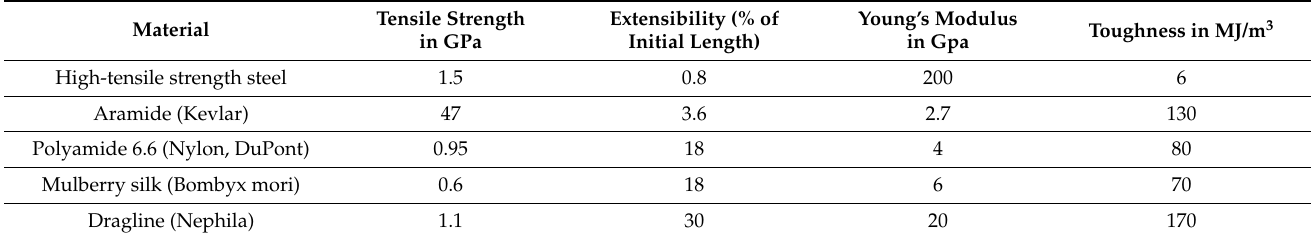
Table 3. Tensile properties of selected man-made and natural fibers [62].